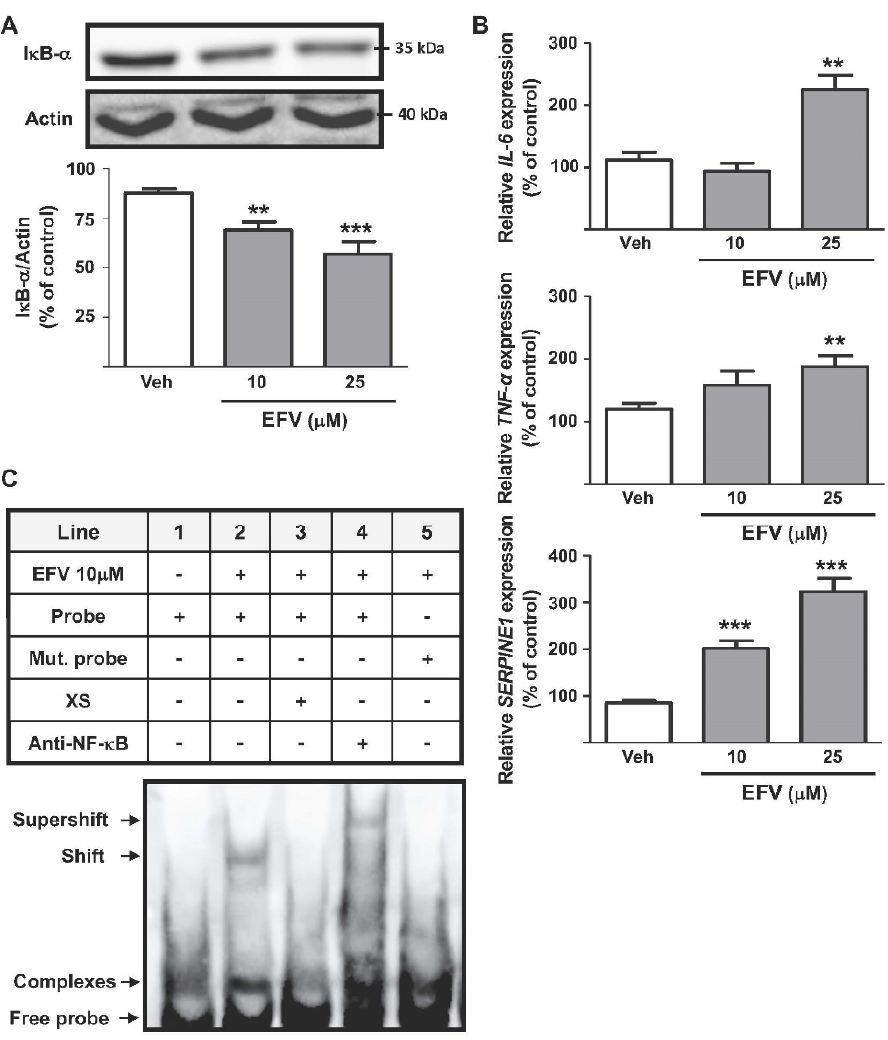
Figure 1. Efavirenz triggers the NF- κ B pathway in Hep3B cells. ( A ) Representative Western Blot image of I κ B- α and summary of densitometry data after 24 h treatment (n = 8). ( B ) Relative mRNA expression levels of the pro-inflammatory cytokines IL-6 and TNF- α (RT-PCR). Data were normalized versus the housekeeping gene β -actin (n = 5). ( C ) EMSA assay showing the binding of NF- κ B (subunit p65) to the promoter of SERPINE1 in EFV-treated cells. Representative image of the different conditions detailed in the table (n = 5). Data (mean ± SEM) were calculated as a percentage of control (untreated cells) and analyzed by a one-way ANOVA multiple comparison test followed by a Newman–Keuls test (** p < 0.01, *** p < 0.001 versus the respective solvent).